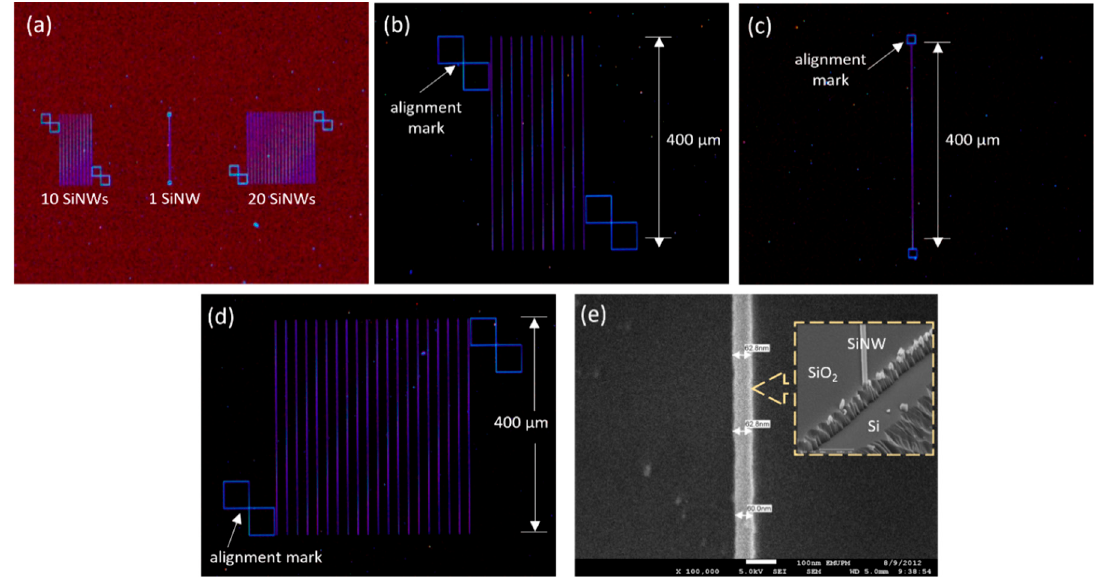
Figure 2. ( a ) HPM images of fabricated SiNWs and zoom image of ( b ) 10 SiNWs, ( c ) single SiNW, and ( d ) 20 SiNWs. ( e ) Top view of 60 nm width of SiNW structure. The inset shows a cross-section of the SiNW fabricated on the SOI sample.